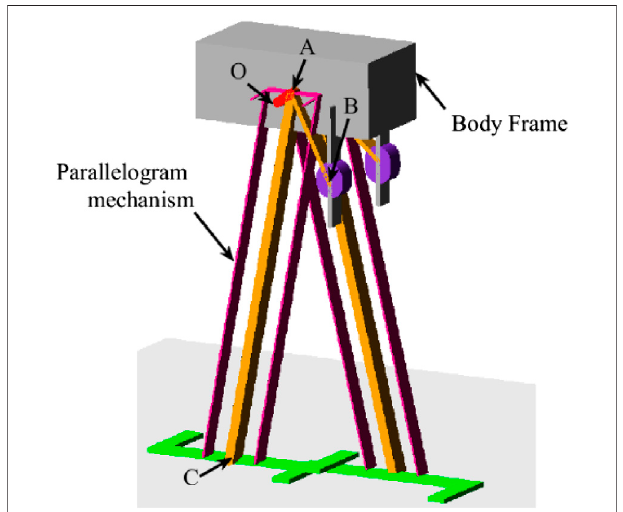
FIGURE 7 | ADAMS model of the proposed design.